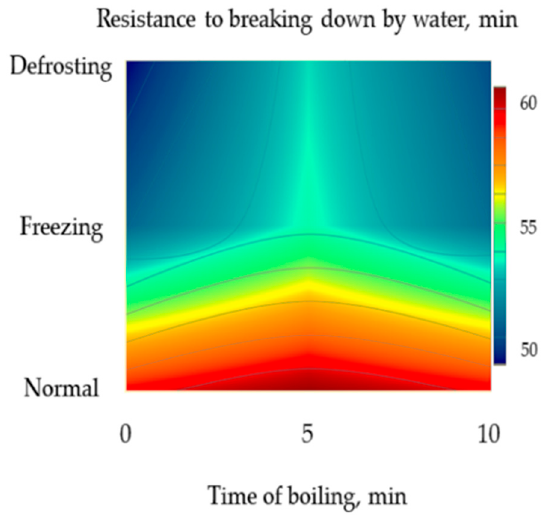
Figure 5. Two-dimensional fuzzy contour plotting for the interactive effect of time of boiling and storage condition on the resistance to breaking down by water of non-wood pellets from pressing residual biomass from distillation of cellulosic bioethanol with liquid-state food waste.